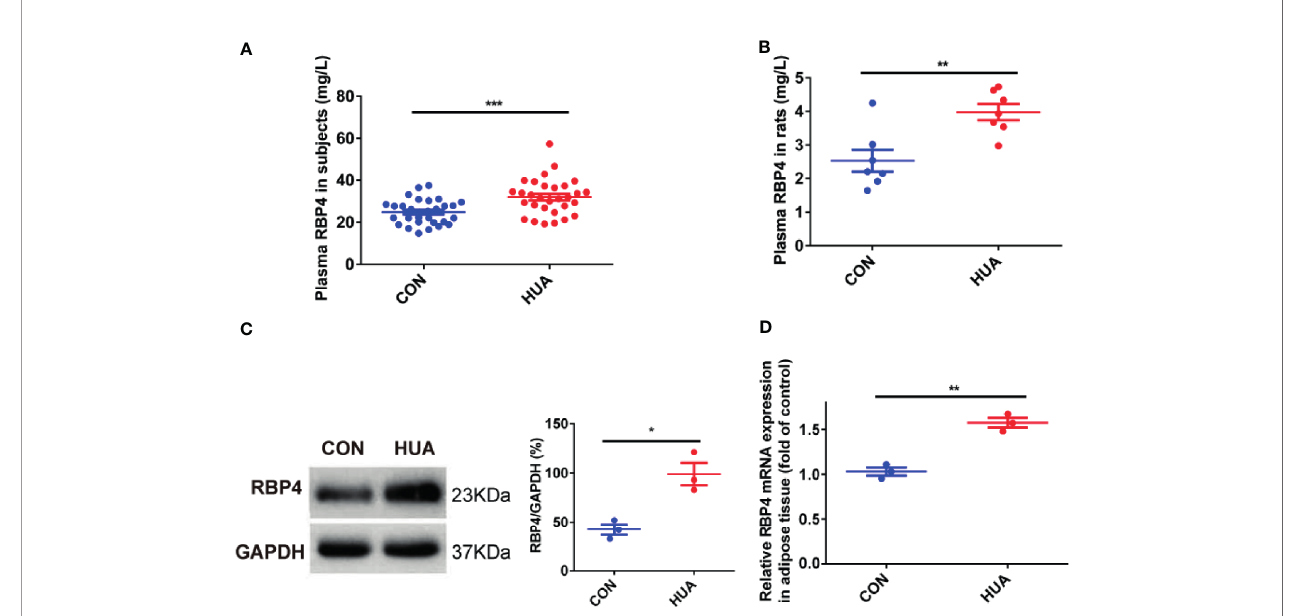
FIGURE 1 | The levels of RBP4 in patients with HUA and HUA rats. (A) The levels of plasma RBP4 in thirty patients with hyperuricemia (HUA) and thirty healthy controls (CON). (B) Twenty-eight weeks male Sprague – Dawley rats were subjected to high yeast diet and potassium oxonate (300 mg/kg, daily, intraperitoneally) for eight weeks along with adenine (100 mg/kg, by gastrogavage) once daily from the fi fth week to induced HUA in rats (HUA, n = 10). Normal diet and vehicle solutions were used in the control group (CON, n = 10). The levels of plasma RBP4 in HUA and CON rats were measured by the speci fi c Elisa kit. (C) About 30 m g protein were loaded and the expression of RBP4 in the adipose tissue of rats was determined by western blot (left panel). The representative views are shown in the left panel and densitrometric quanti fi cation analysis for RBP4 is shown in the right panel. (D) The mRNA expression of RBP4 in the adipose tissue of rats was determined by RT-PCR. Results are represented by mean ± SEM. * P < 0.05, ** P < 0.01, *** P <